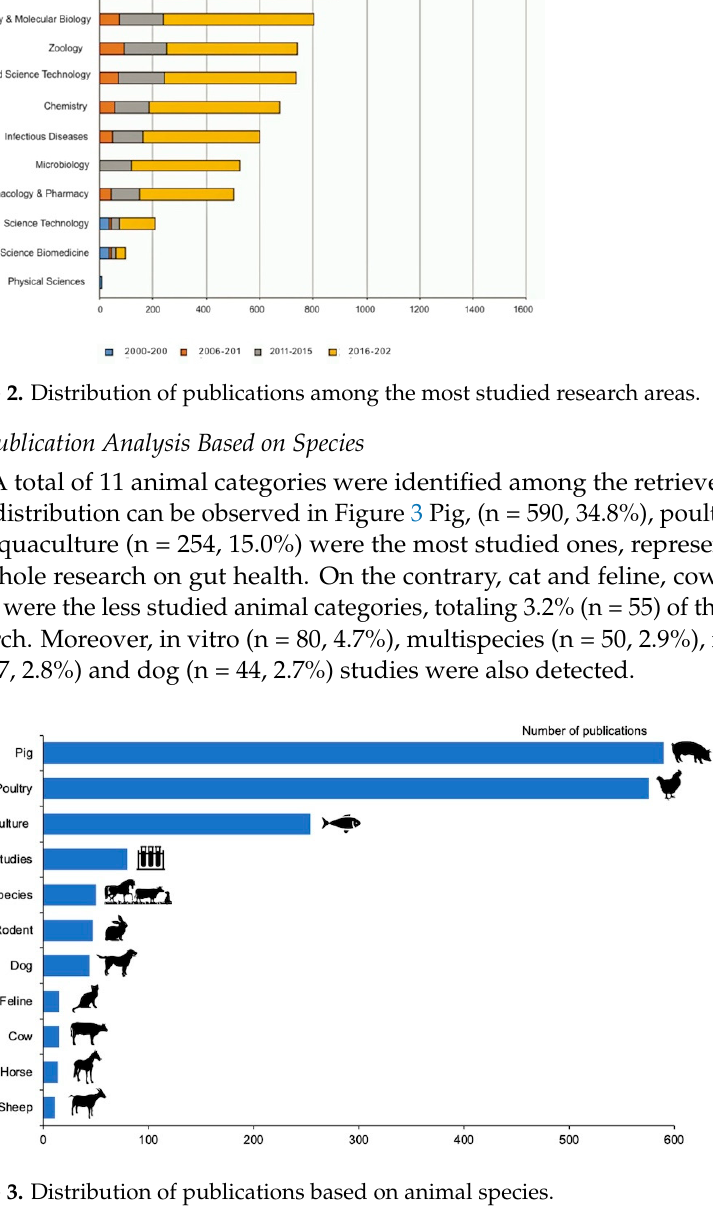
Figure 3. Distribution of publications based on animal species.